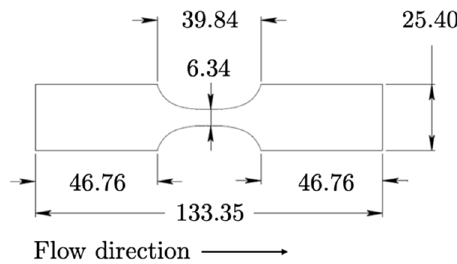
Figure 1. Fatigue test sample